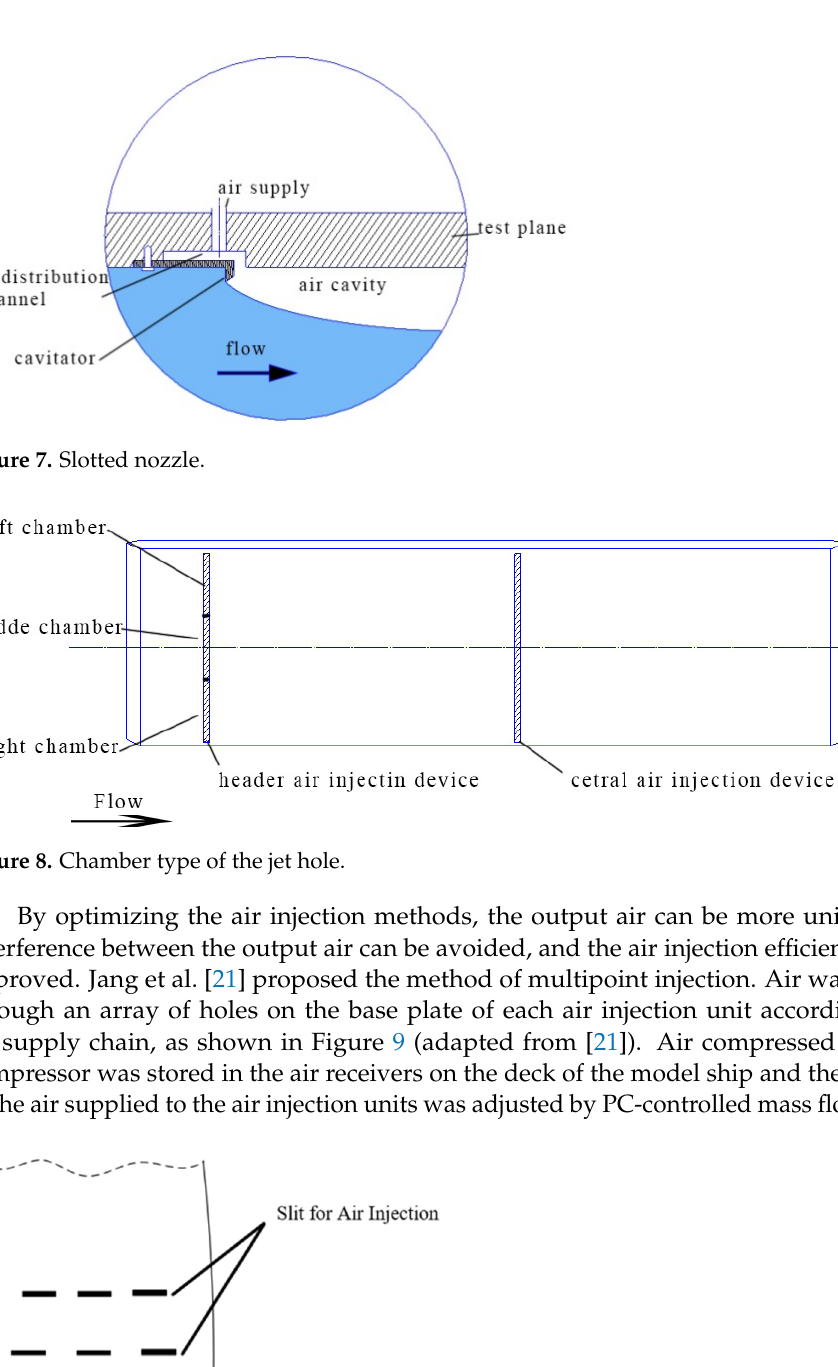
Figure 9. Arrangement of air injection units.